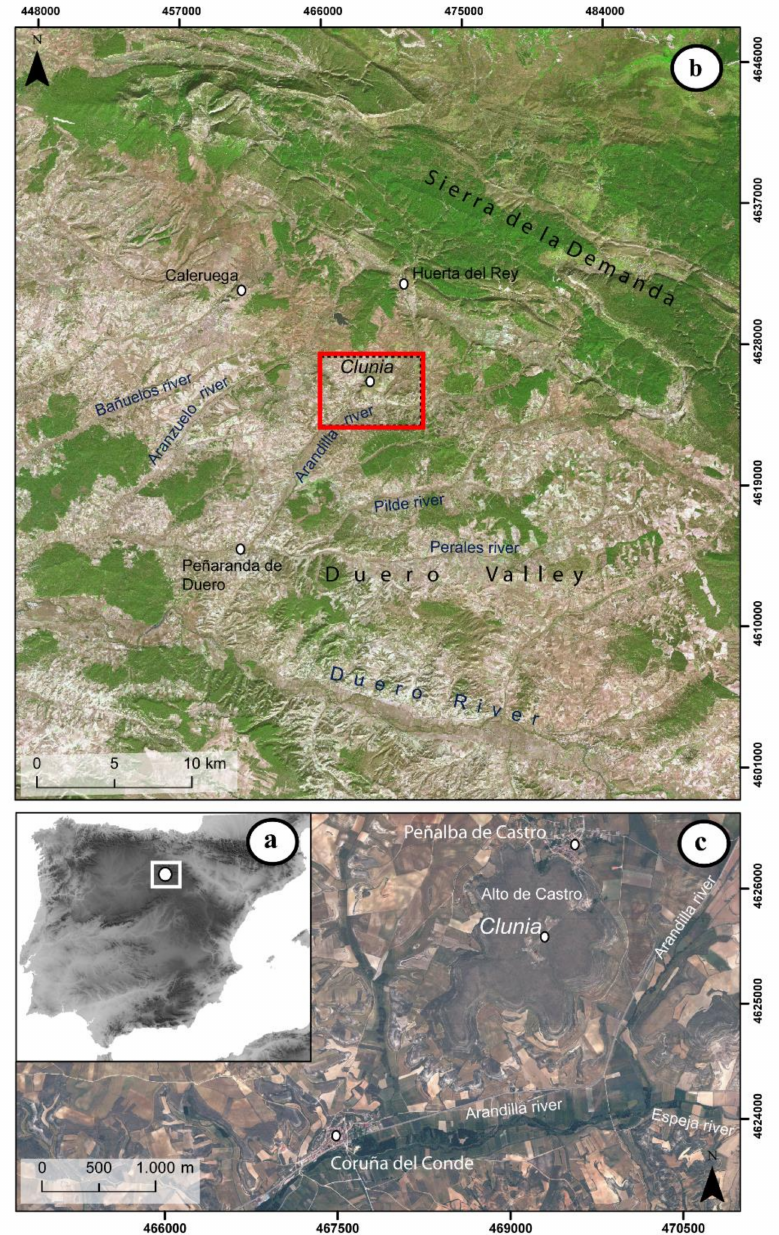
Figure 1. Location of Clunia. Sources: National Geographic Institute (IGN), National Plan for Aerial Orthophotography (PNOA), Maximum resolution (20 cm). ( a ) Location of Clunia in Spain ( b ) Location of Clunia in the Douro Valley ( c ) Clunia and the Alto del